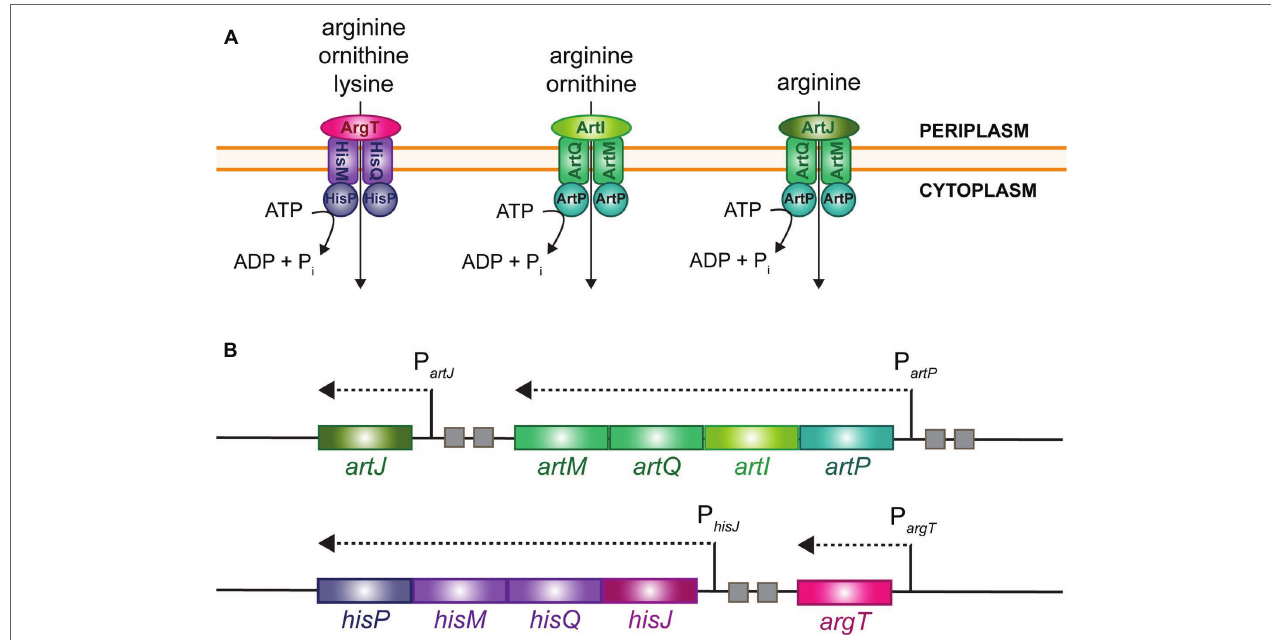
FIGURE 1 | Schematic representation of the different import systems for arginine in E. coli (A) and organization of the cognate gene clusters on the chromosome (B) . Small squares represent ARG